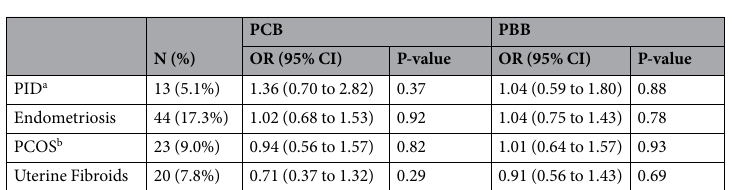
Table 2. Associations between exposures and gynecological outcomes. Adjusted for age, BMI, and total lipid levels. Total PCB levels adjusted for total PBB and total PBB levels adjusted for total PCB. OR = odds ratio. CI = confidence interval. a Pelvic inflammatory disease. b Polycystic ovarian